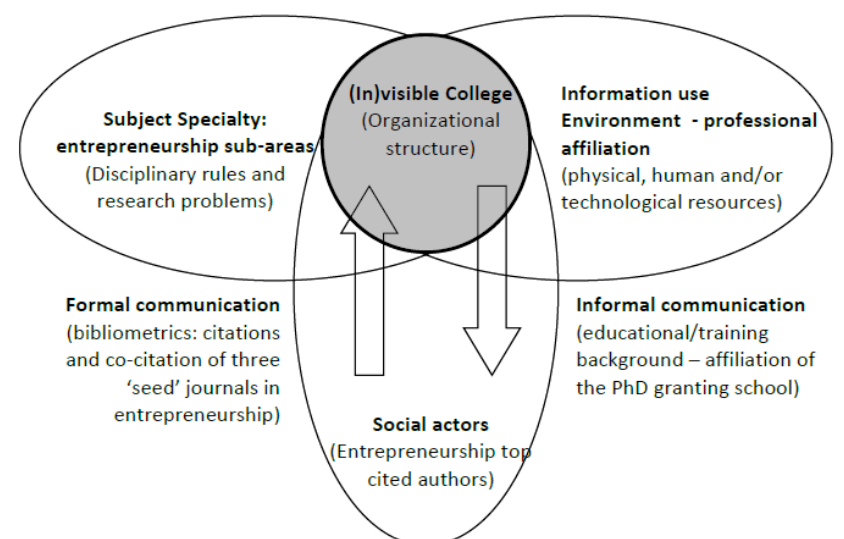
Fig. 1. Conceptual model to analyze the structure of an invisible college in entrepreneurship. Source : In Teixeira (2011: 10), and adapted from Zuccala (2006: 156) The use of three core journals, instead of only a single journal analysis